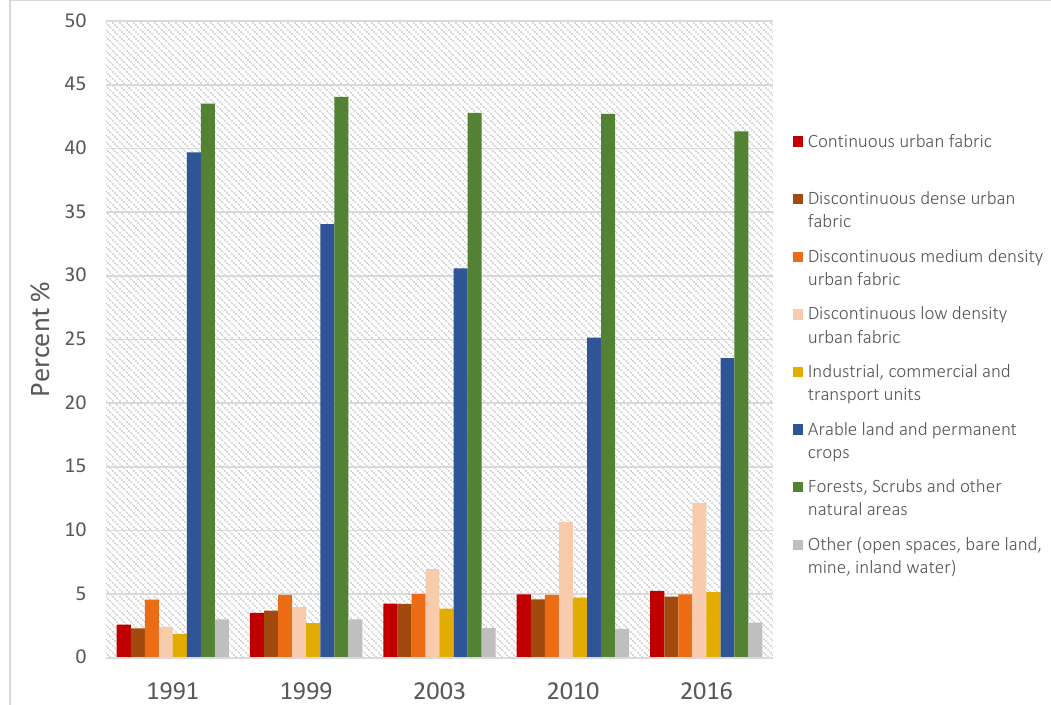
Figure 2. Summary of statistics based on the five classified maps and percentage of LUC categories.